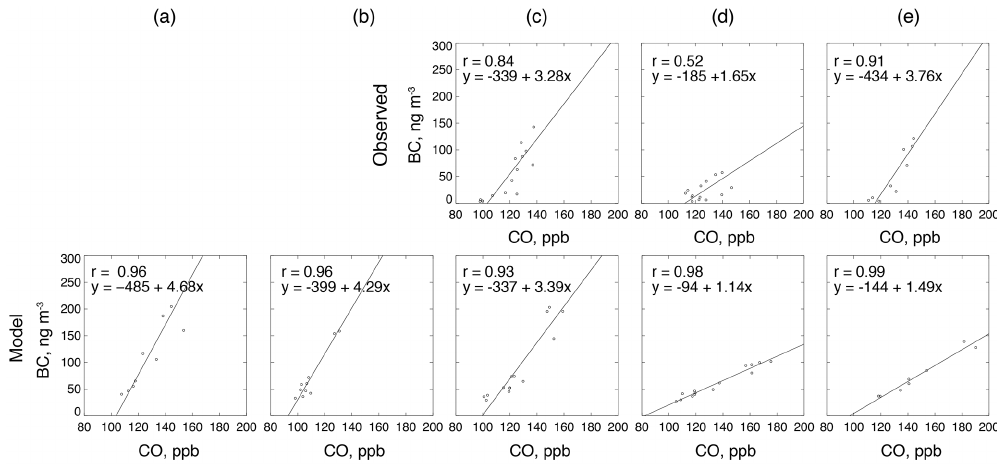
Figure 11. Scatterplots of observed (top) and simulated (bottom) BC vs. CO concentrations at ATTO for (a) – (e) peaks in Fig. 10. Reduced- major-axis (RMA) regression statistics and linear fits are shown